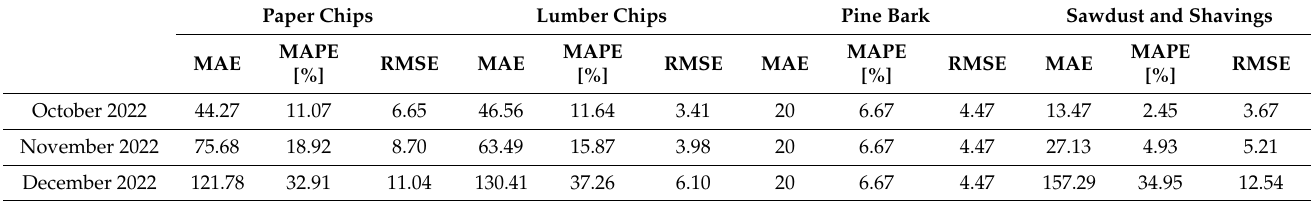
Table 8. Summary of MAE, MAPE and RMSE for the prediction using ARIMA.